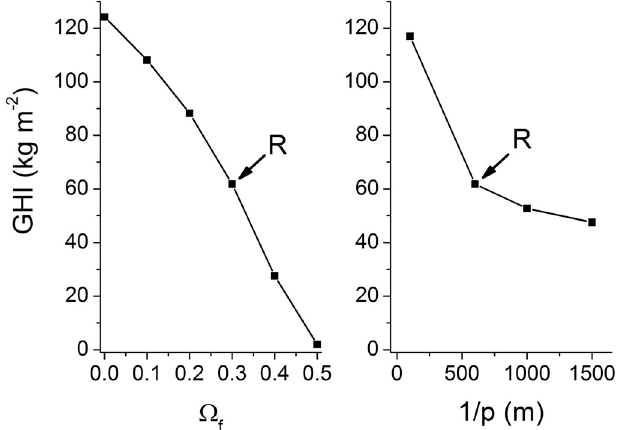
Figure 20. Effect of sediment compaction on gas hydrate accumulation. The porosity after ) and the attenuation coefficient for the down-core decrease in porosity (p) compaction ( Ω f are varied while the porosity at the sediment surface is maintained at the reference value of = 0.74 [s. Equation (15)]. Compaction decreases towards the right in both plots. R Ω 0 indicates the reference case.